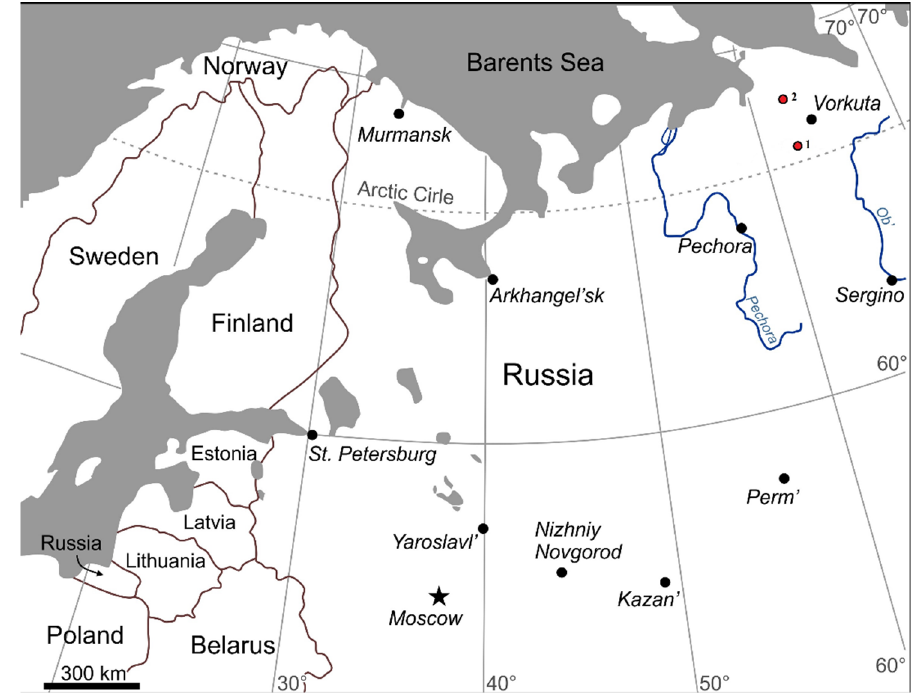
Figure 1. Location of sampling area: Plots 1-1, 1-2 (1) and Plots 2-1, 2-2 (2).